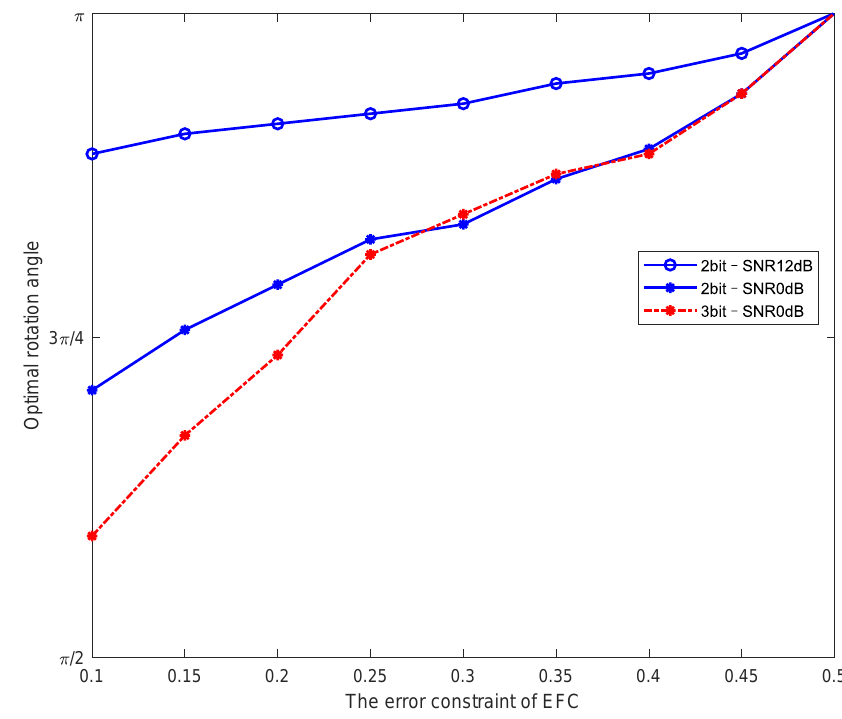
Figure 10. The optimal rotation angle vs error constraint of EFC P E